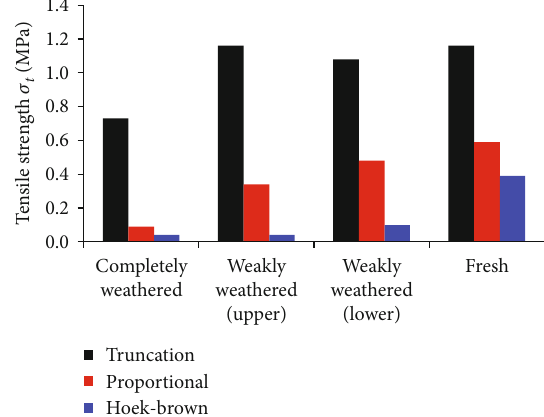
Figure 13: Tensile strength of rock masses estimated by three di ff erent methods.